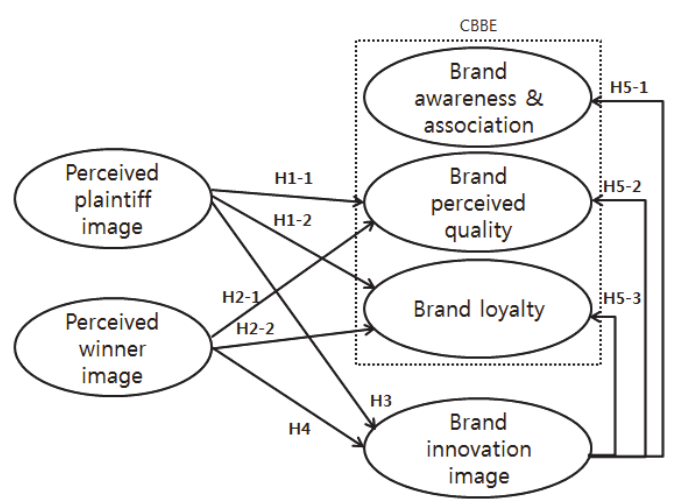
<Figure 2> Research model for PIL